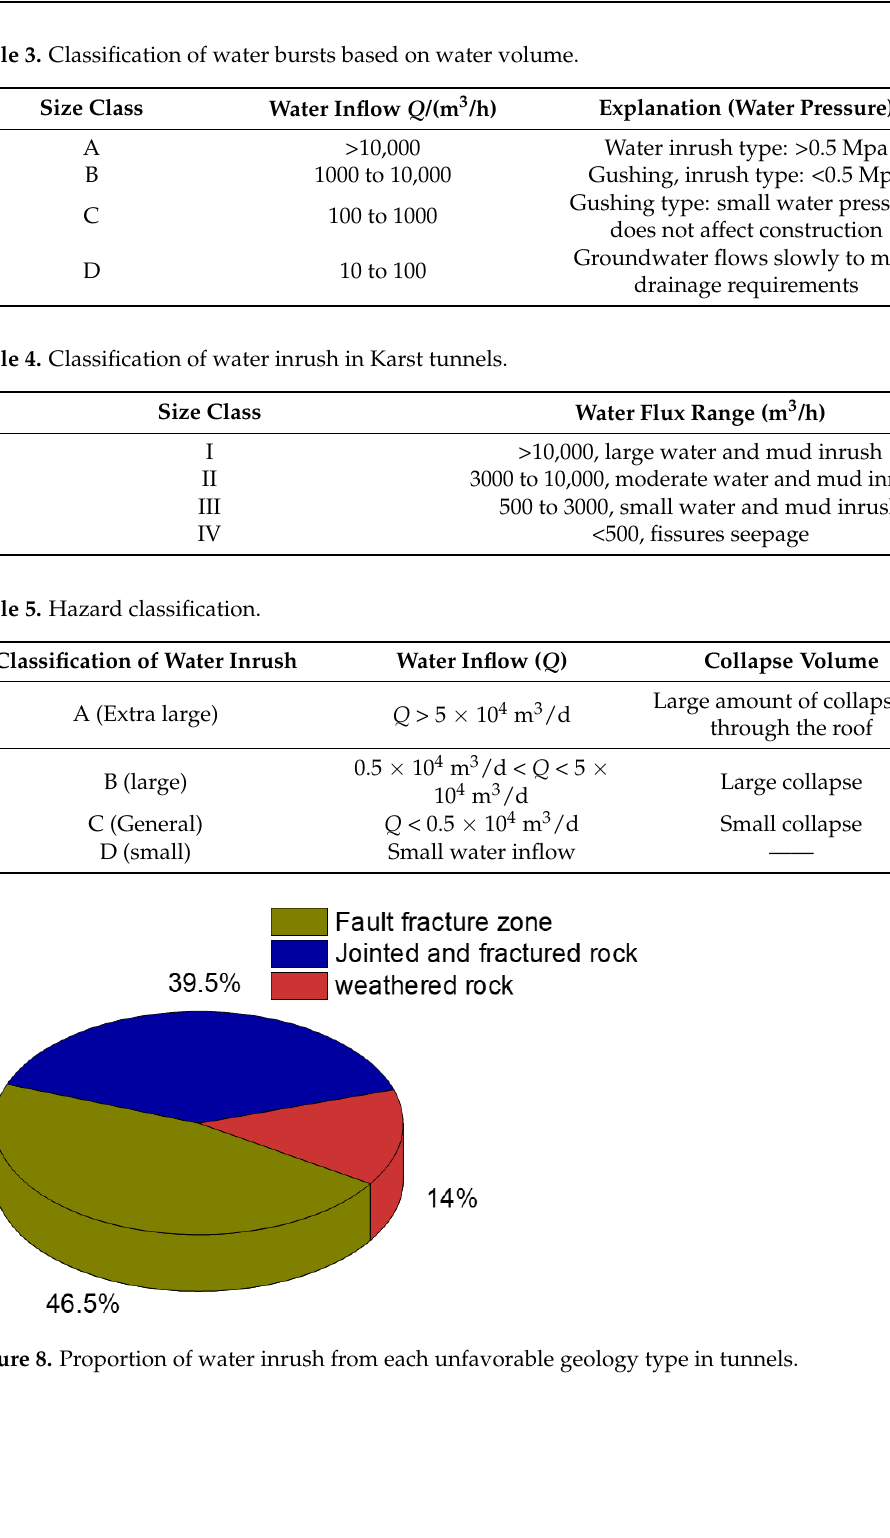
Figure 9. Water inrush level distribution of three kinds of unfavorable geology in tunnels. ( a ) Fault fracture zone; ( b ) jointed and fractured rock; ( c ) weathered rock Figure 10. Percentage of water inrush inflow of subsea tunnels and mountain tunnels.